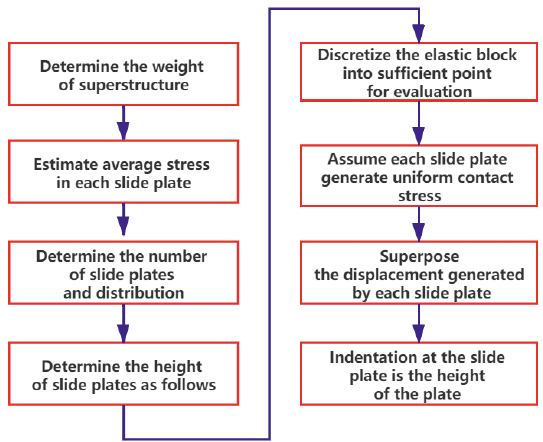
Figure 9. Flowchart of the optimal design based on the proposed contact